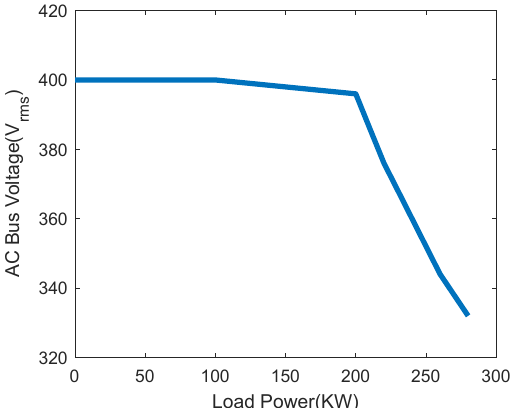
Figure 18. Change of microgrid AC bus voltage with load power.